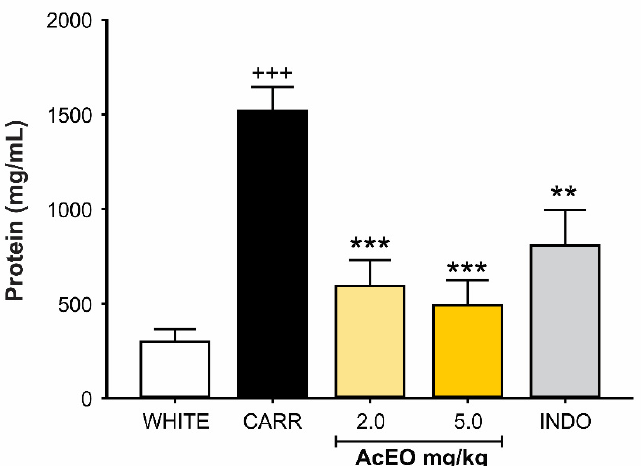
also like non-steroidal anti-inflammatory indomethacin ( p = 0.371 and 0.643, respectively) (Figure 6).